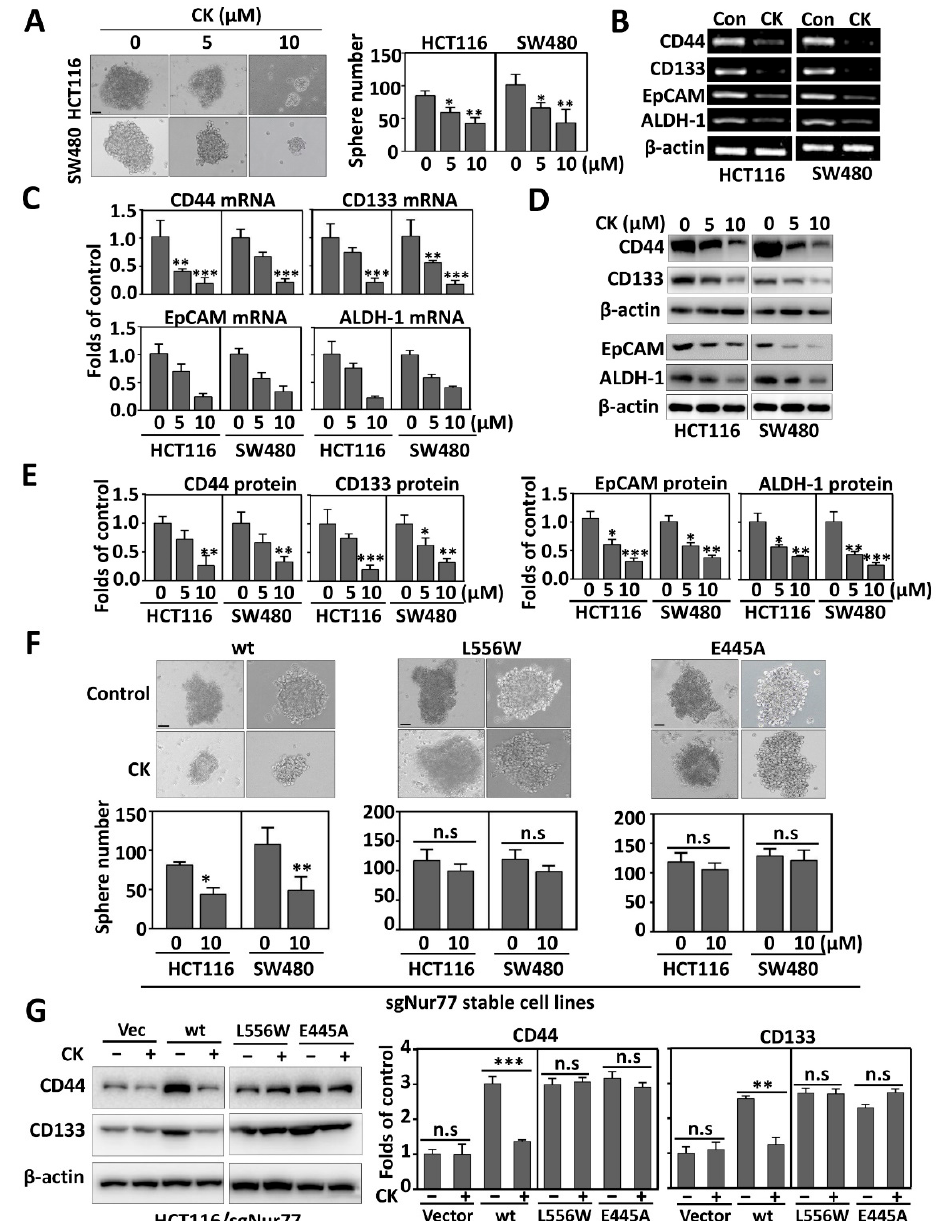
Figure 2. CK inhibits CSC phenotypes dependent on Nur77. ( A ) CRC cells were cultured at 1% O 2 in serum-free CSC-selective medium and treated with CK (0, 5, or 10 µ M) every 48 h for 2 weeks. Spheres (>50 µ m) were photographed (left) and counted (right). (Scale bar, 50 µ m). ( B ) CRC cells were cultured at 1% O 2 and treated with vehicle or 10 µ M CK for 24 h. The mRNA expression levels of CSC markers were examined by RT-PCR. ( C ) CRC cells were exposed to CK (0, 5, or 10 µ M) for 24 h under 1% O 2 . The RNA was purified for qPCR assay. ( D ) CRC cells were cultured and treated with CK in the same way as that described in ( C ). The lysates were subjected to a Western blotting assay. ( E ) Quantification of protein levels based on bot grey intensities in ( D ). ( F , G ) The endogenous Nur77 in CRC cells was knocked out by CRISPR/Cas9 and then stably re-expressed with Nur77/wt, Nur77/L556W, or Nur77/E445A. The cells were cultured as tumor spheres with similar treatment and analysis as described in ( A ) ( F ) or grown in RPMI-1640 medium with 24 h treatment of CK (0 or 10 µ M) followed by assaying the changes in CSC makers. (Scale bar, 50 µ m). ( G ). * p < 0.05; ** p < 0.01; *** p < 0.001 vs. respective control. n.s.= non-significant. Molecular weights for proteins are indicated in the full, uncropped, annotated Western blot images (Figure S4).